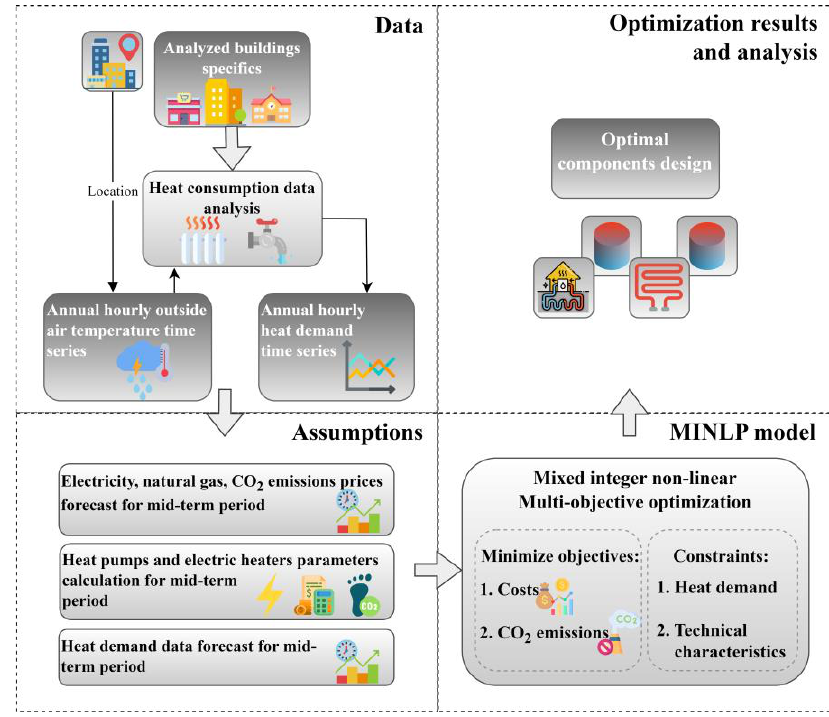
Figure 1. The scheme of the methodology framework for the optimization problem.